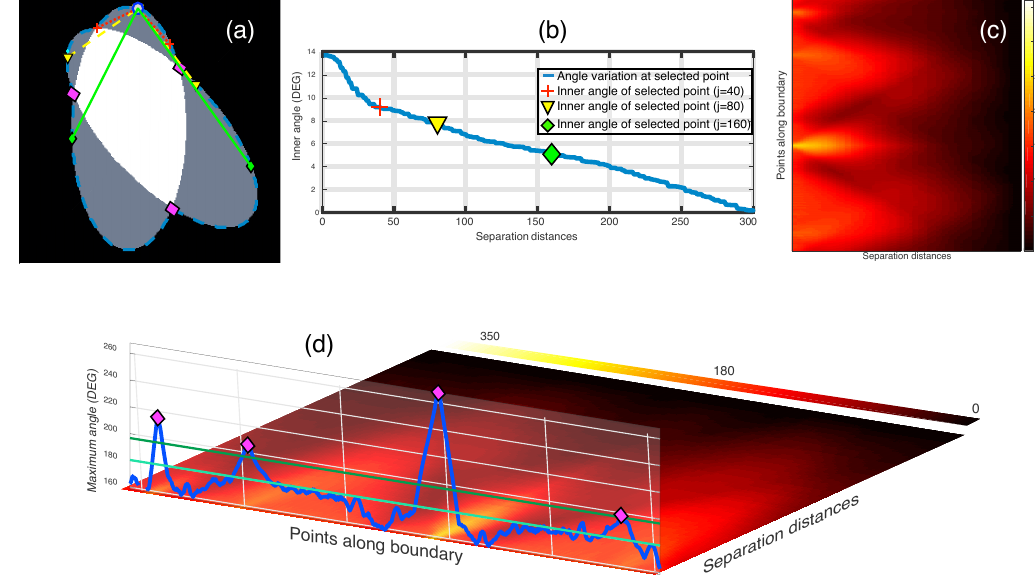
Figure 7. Junction detection on overlapping objects through the maximum intensity projection of the anglegram matrix. ( a – c ) Representation of inner point angle calculation and generation of the anglegram matrix . ( a ) Represents a synthetic clump with its boundary outlined (blue - -), where a point (blue in the boundary will have various inner point angles per separation j ; All the inner point angles for the highlighted point are displayed in ( b ); ( c ) Shows the anglegram matrix , and the definition of ˆ θ max is represented in ( d ) along the boundary points. Detection of junctions are shown with (magenta). Notice the two horizontal lines representing mean ˆ θ max and mean ˆ θ max + 0.75std ˆ θ max . [17] Reproduced with